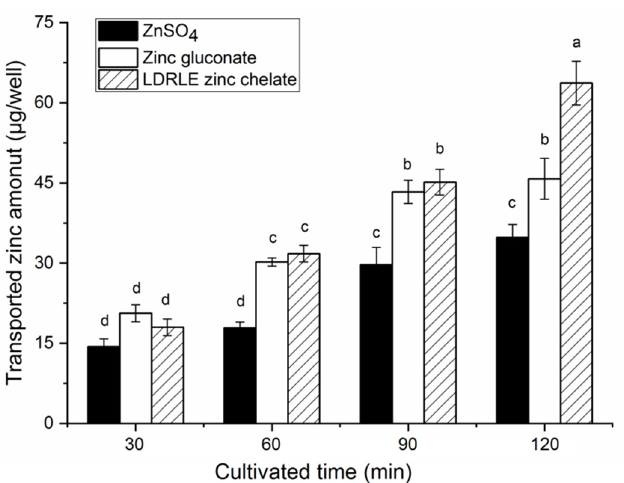
Figure 10. Zinc transport contents at the basolateral sides of Caco ‐ 2 cell monolayers of LDRLE ‐ zinc chelate, zinc sulphate and zinc gluconate. Different lowercase letters (a–e) above the bars indicate chelate, zinc sulphate and zinc gluconate. Different lowercase letters ( a – d ) above the bars indicate significant differences ( p < 0.05). significant differences ( p <